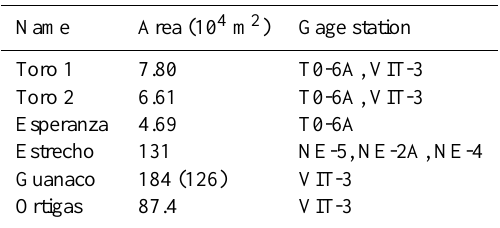
Table 2. Instrumented glaciers in the study area (for which ablation, accumulation and net balance data are available). For the Guanaco glacier we indicated in parenthesis the area of the glacier which is within VIT-3 catchment (contributing area). For gage station char- acteristics refer to Table